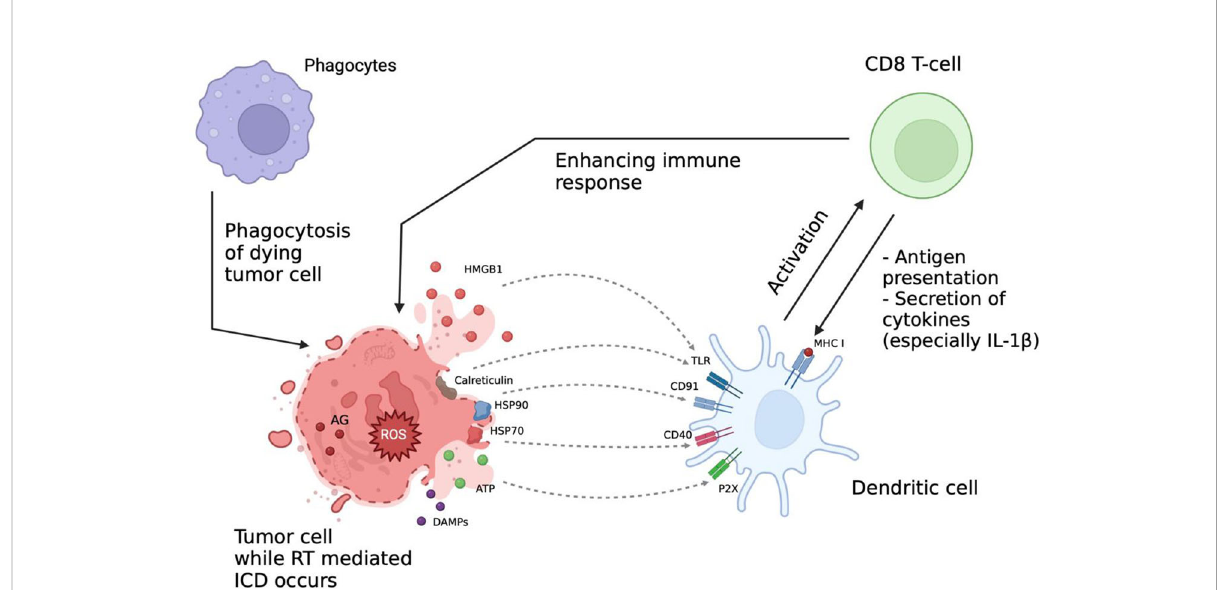
FIGURE 2 Immunologic aspects of radiation therapy (RT). RT effect is mediated via formation of reactive oxygen species (ROS) affecting the DNA structure and leading to immunogenic cell death (ICD). This process is accompanied by release of tumor antigens (AG) and damage-associated molecular patterns (DAMPs) into extracellular space and activation of signaling pathways involved into the immune response. After RT the interaction between immune cells is increased, ICI can further enhance it, thus increasing the overall therapeutic ef fi cacy. AG, tumor-associated antigens; DAMPs, damage associated molecular patterns; ICD, immunogenic cell death; ROS, reactive oxygen species; HMGB1, high-mobility group protein B1; HSP70, heat shock protein 70; HSP90, heat shock protein 90; TLR, toll-like receptors; MHC I, major histocompatibility complex class